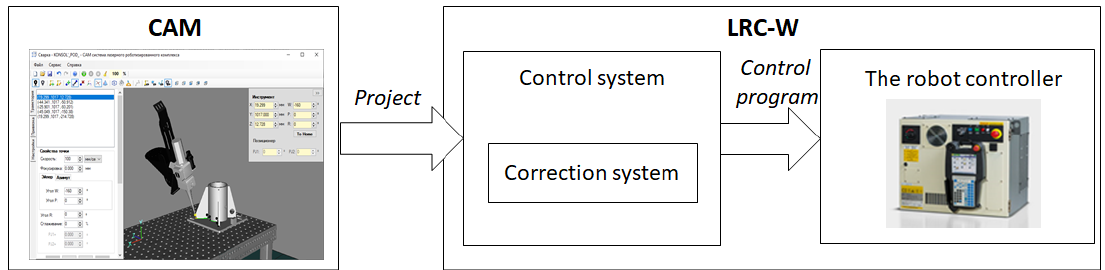
Figure 7. Scheme of the process of transferring the project from CAM to the LRC-W industrial complex using the trajectory correction system.